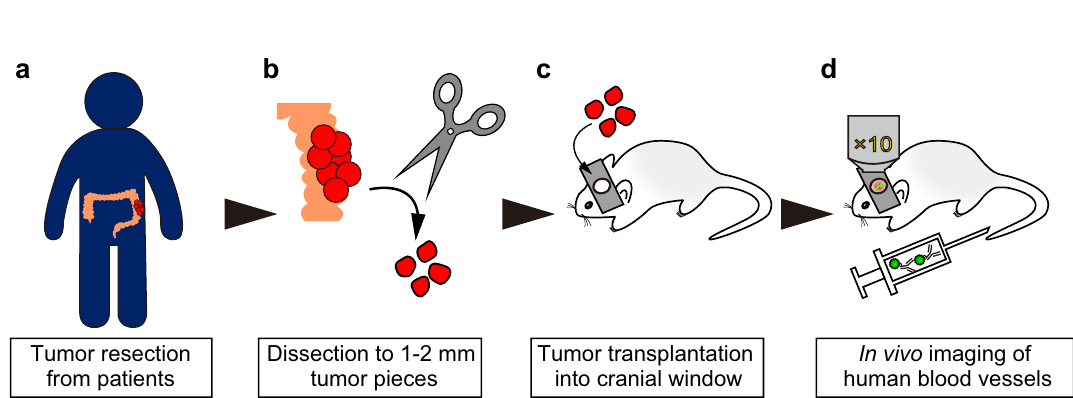
Figure 1. Development of a continuous imaging model of human blood vessels using human tumor tissues. ( a ) Human tumor was freshly resected from cancer patients. ( b ) Tumors were cut into 1–2 mm fragments with scissors. ( c ) Tumor fragments were transplanted into a cranial window in NOD-Scid mice. ( d ) Mice were intravenously injected with Alexa Fluor 488-conjugated anti-human CD31 monoclonal